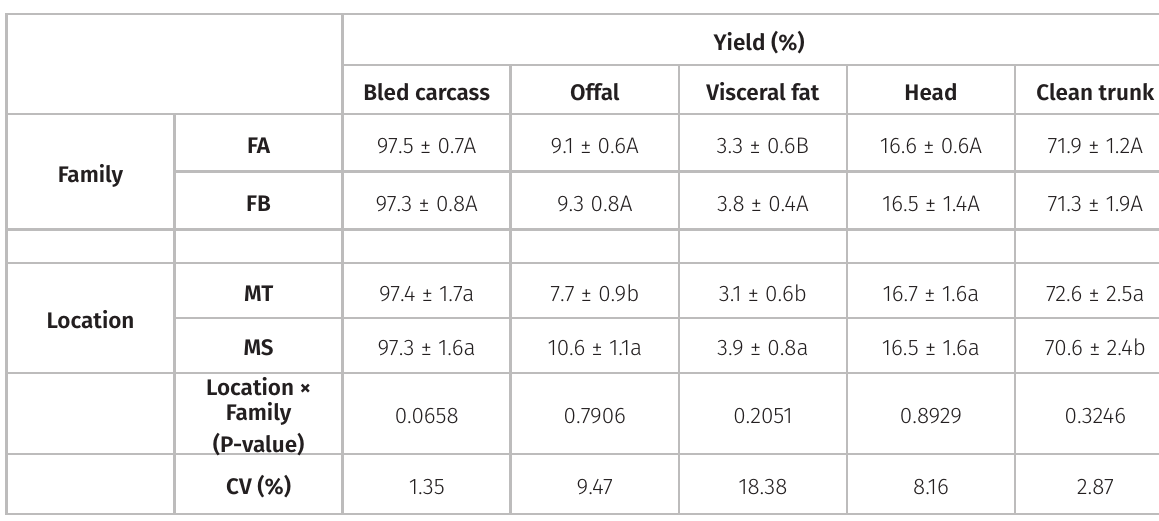
Table I - Body yields of two tambaqui ( Colossoma macropomum ) families (FA and FB) from the second generation of selective breeding, farmed in excavated ponds for 431 days, in Santo Antônio de Leverger (MT: Mato Grosso) and Campo Grande (MS: Mato Grosso do Sul).